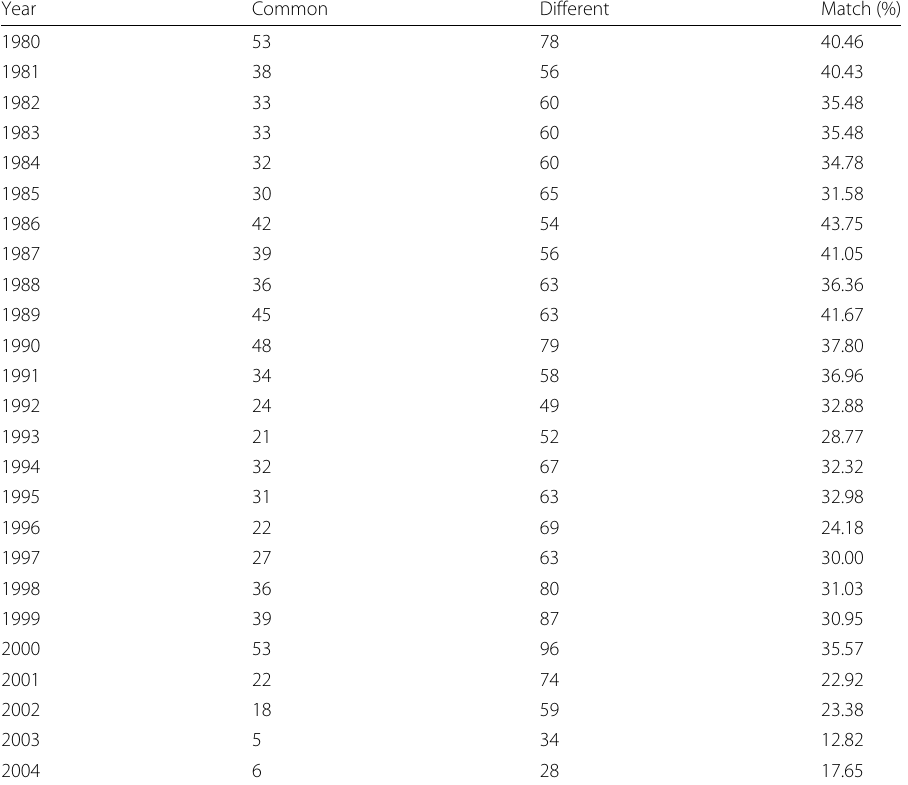
Table 3 Matching rates of central nodes by the community mapping method and the betweenness centrality